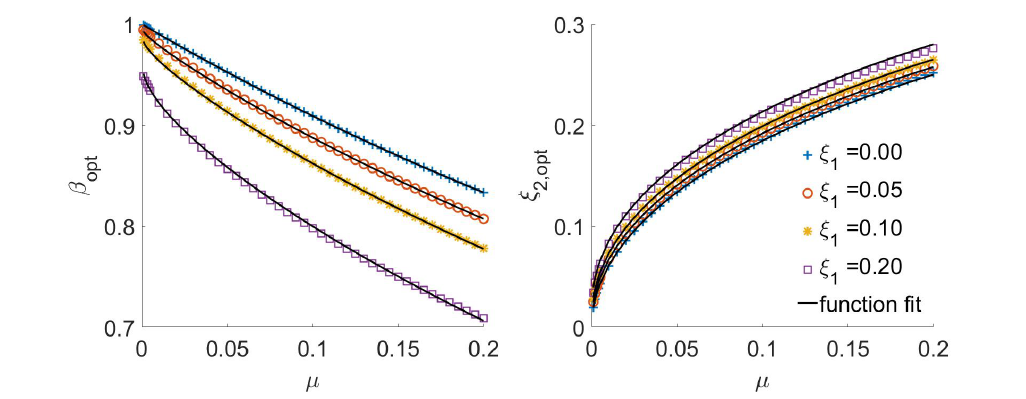
Figure 3. Optimum TMD parameters: TF No. 1.